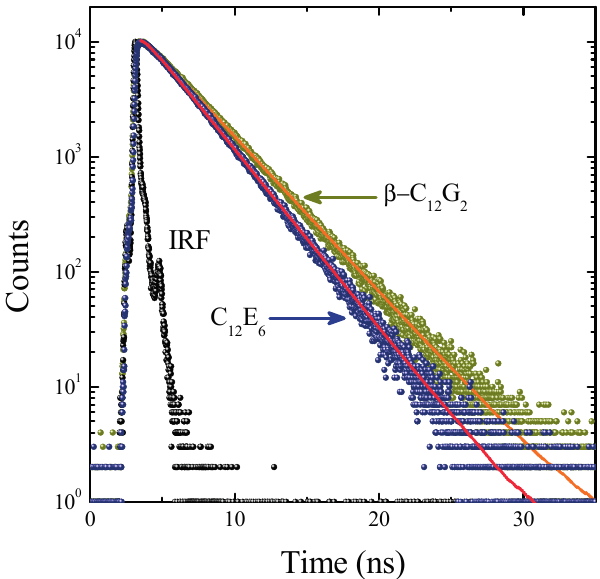
Figure 3. Fluorescence decay curves of C6 together with the instrumental response function (IRF) in micelles of β -C 12 G 2 and C 12 E 6 at 25 °C ( λ exc = 405 nm and λ em = 505 nm). The solid lines through the data points represent the best fits to single-exponential